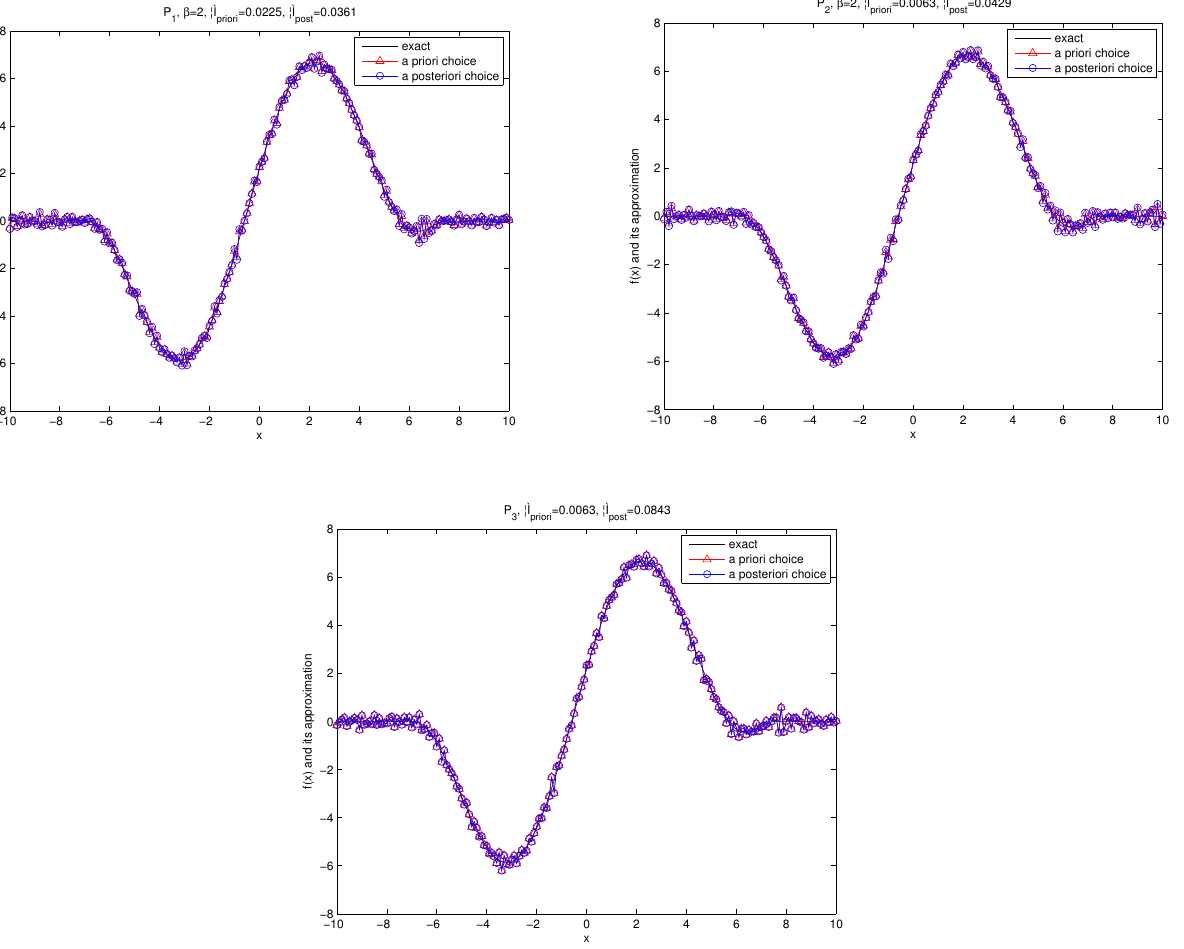
Figure 8. The exact solution and the regularized solutions of Example 2 for α = 1 under the a priori Figure 8: The exact solution and the regularized solutions of Example 2 for α = 1 under parameter choice and the a posteriori parameter the a-priori parameter choice and the a-posteriori parameter choice.